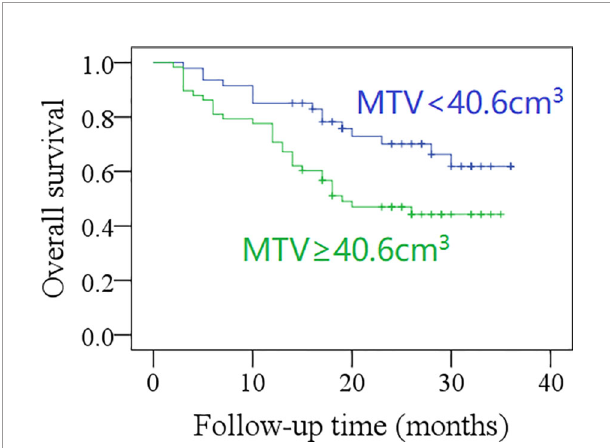
FIGURE 2 | Comparison of progression-free survival in patients with different total maximum standard uptake values (SUVmax) ( p = 0.001).